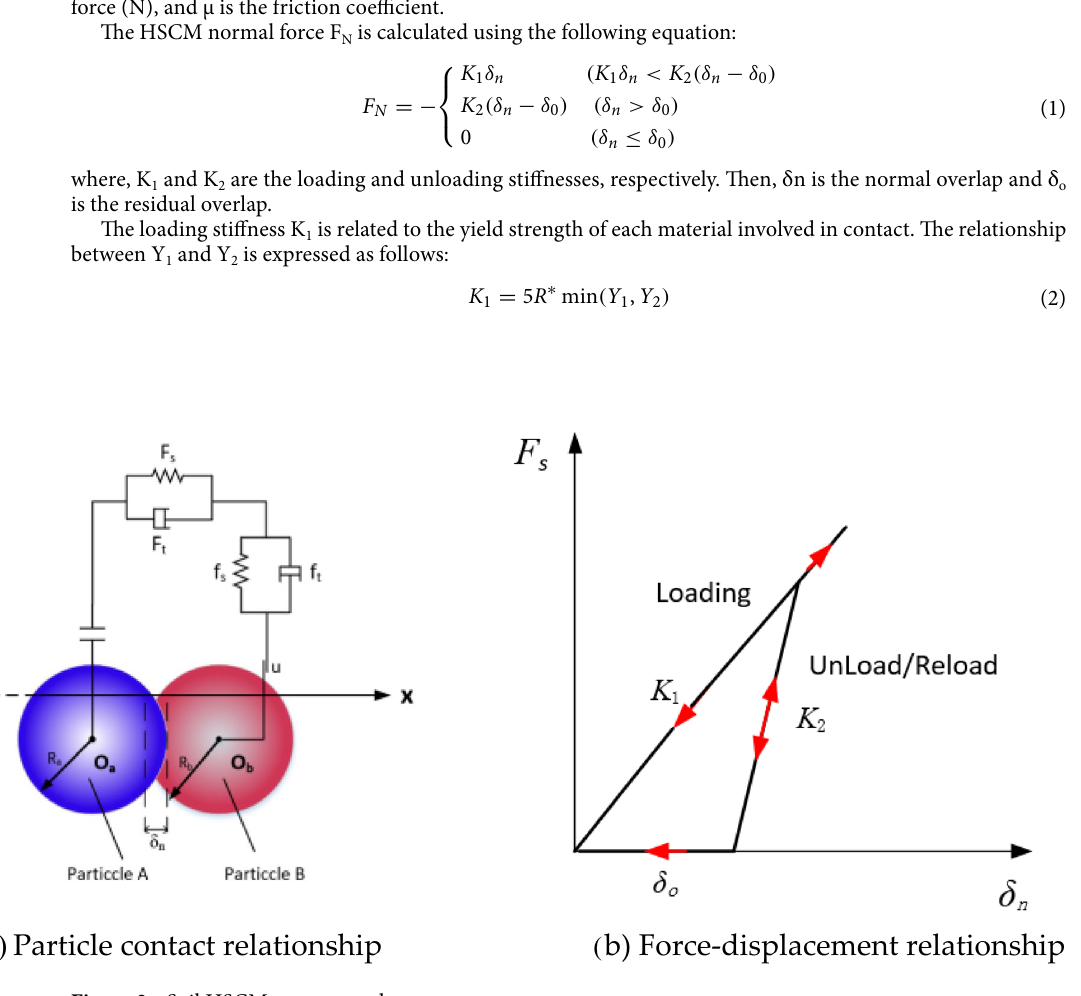
Figure 2. Soil HSCM contact